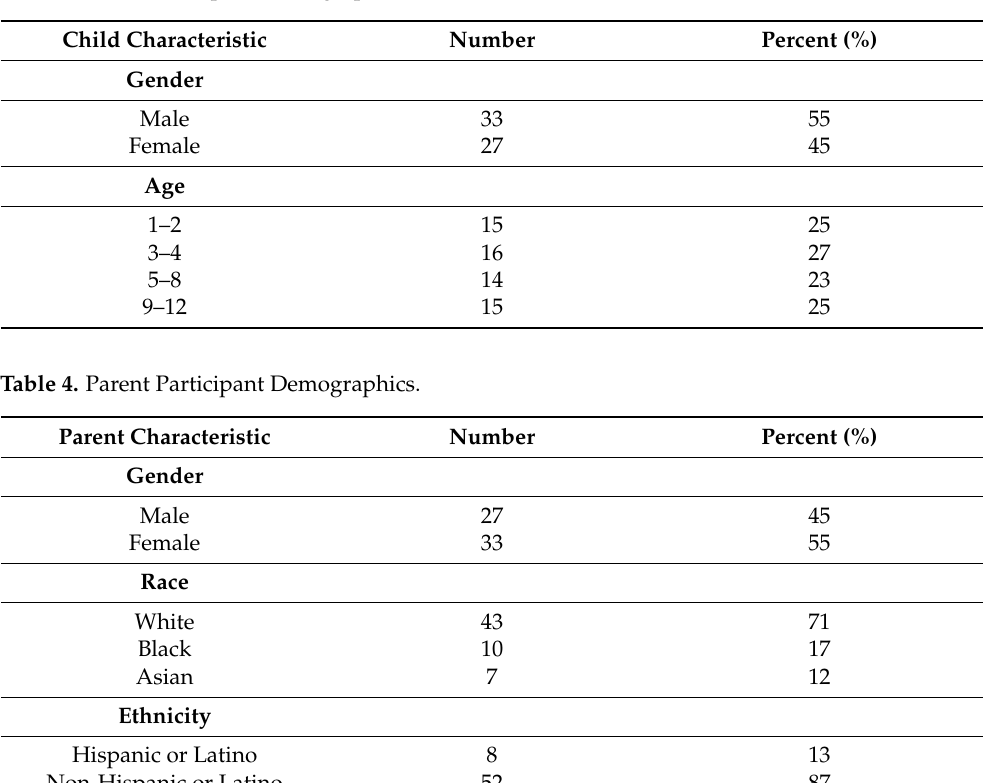
Table 3. Child Participant Demographics.